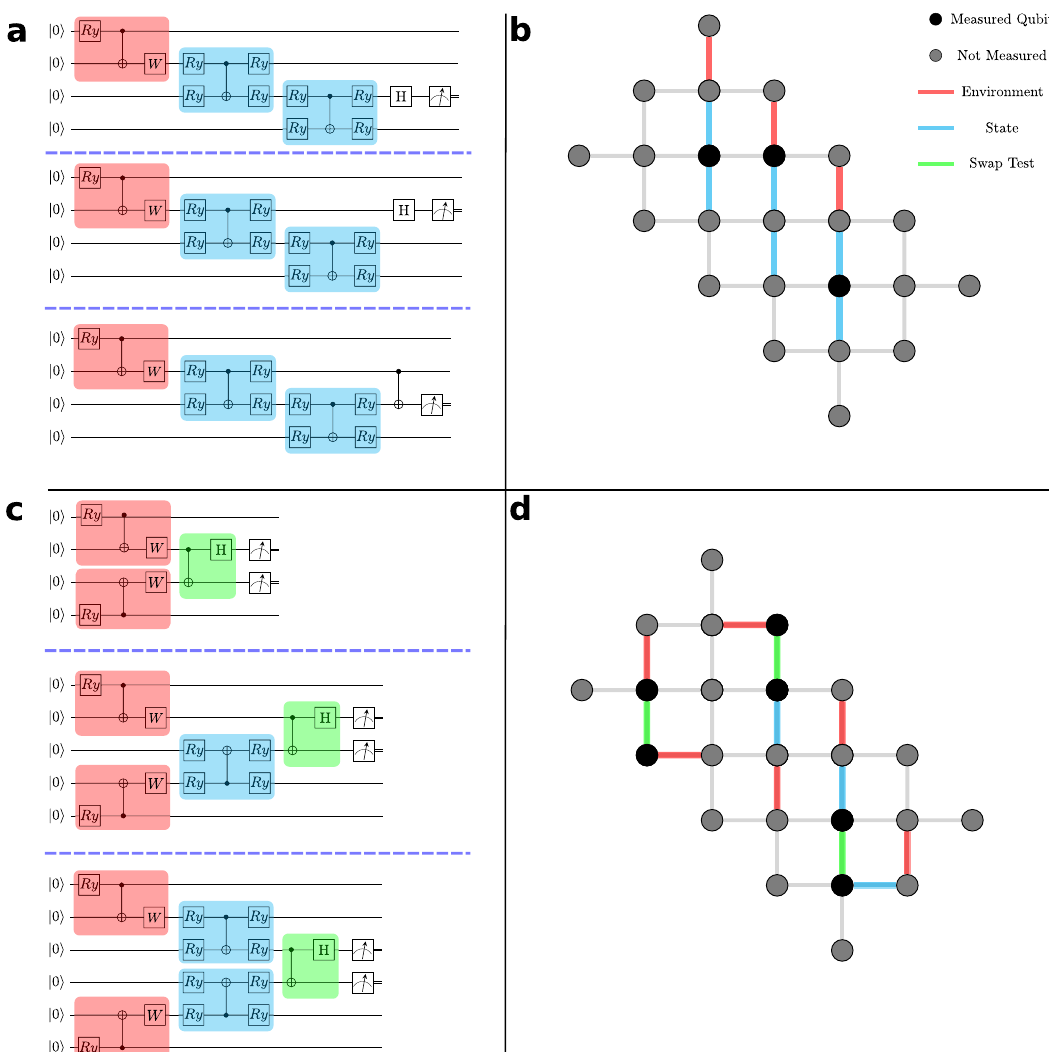
Fig. 1 | TranslationallyInvariant Circuit Matrix Product States for groundstate optimisation.a iMPScircuitstocalculatethethreetermsinthe Ising Hamiltonian. The blue boxes indicate realisations of the state unitary U with its factorisation to the Rainbow gate set. The red boxes highlight the environment tensor V . Ry gates refertothePauli-Yrotationgates, Ry ð θ Þ = exp ð(cid:2) i σ y θ Þ where σ y isthePauli-Ymatrix. The W gate is an arbitrary single qubit unitary with three free parameters. Para- metersaresharedacrossthebluetensorstoenforcetranslationalinvariance.There are eight free parameters in total, four from the environment (red) and four from